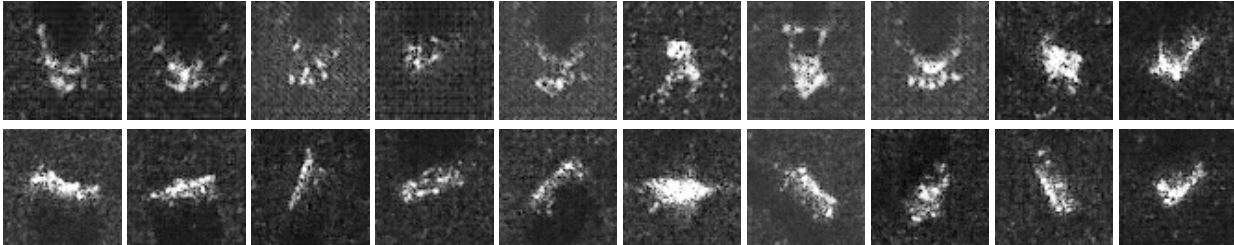
Figure 8. The filtered counterfactual target samples of ten categories. According to the order: 2S1, BMP2, BRDM2, BTR60, BTR70, D7, T62, T72, ZIL131, and ZSU23/4. Row 1: The counterfactual target samples filtered by proposed filtering process. Row 2: The counterfactual target samples filtered by SVM.